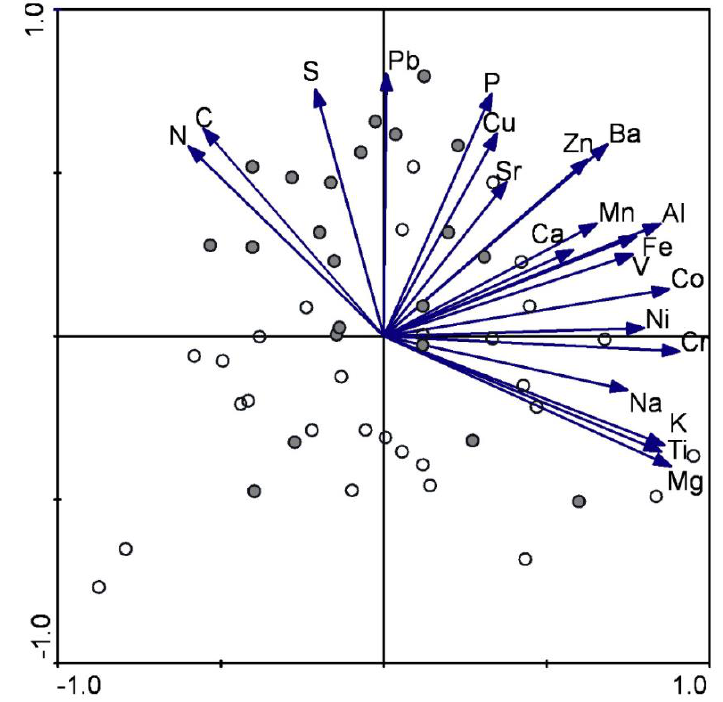
Figure 9. PCA plot of predisturbance (bottom) samples and chemical components results; log10 transformation used.